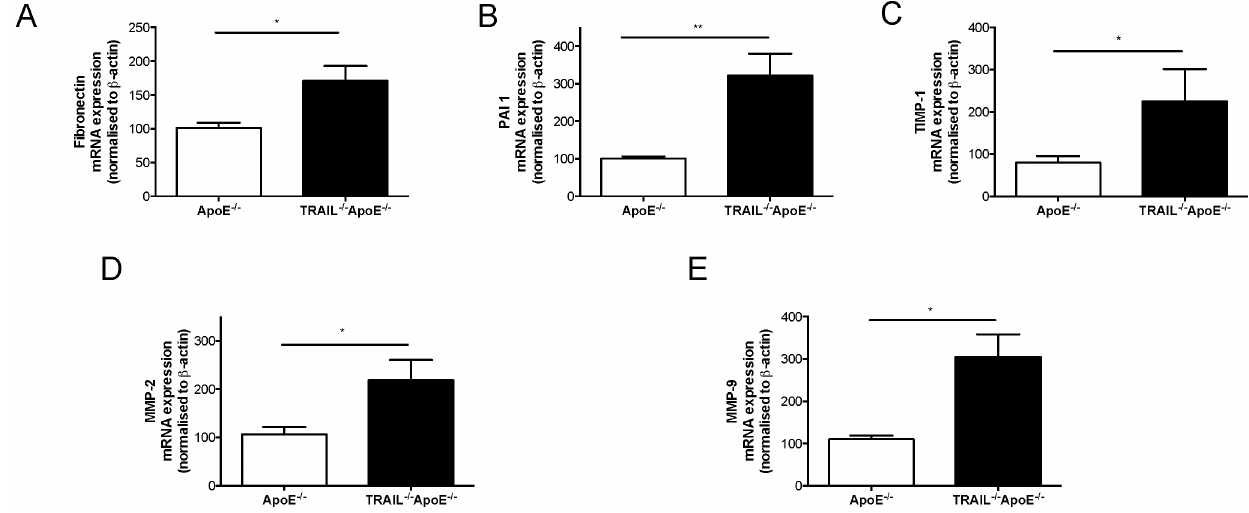
Figure 2. Kidneys from TRAIL -/- ApoE -/- mice have increased expression of genes indicative of fibrosis. mRNA expression for (a) fibronectin, (b) PAI-1, (c) TIMP-1, (d) MMP-2 and (e) MMP-9 from kidneys. All levels were normalized to b -actin; n=6/ genotype. Results are expressed as mean 6 SEM, *p , 0.05 and **p , 0.01 by Mann-Whitney U test.